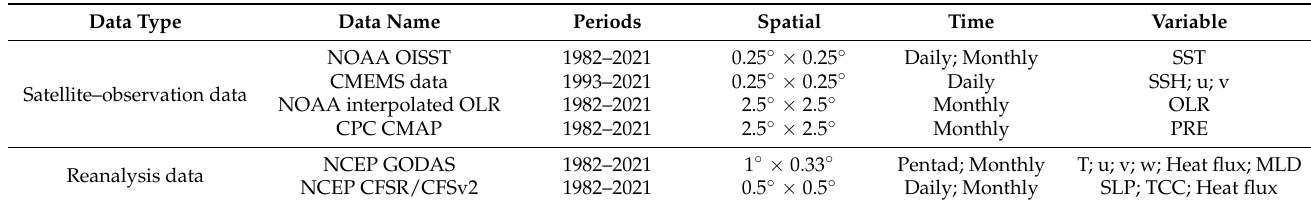
Table 1. List of the datasets and key components in this